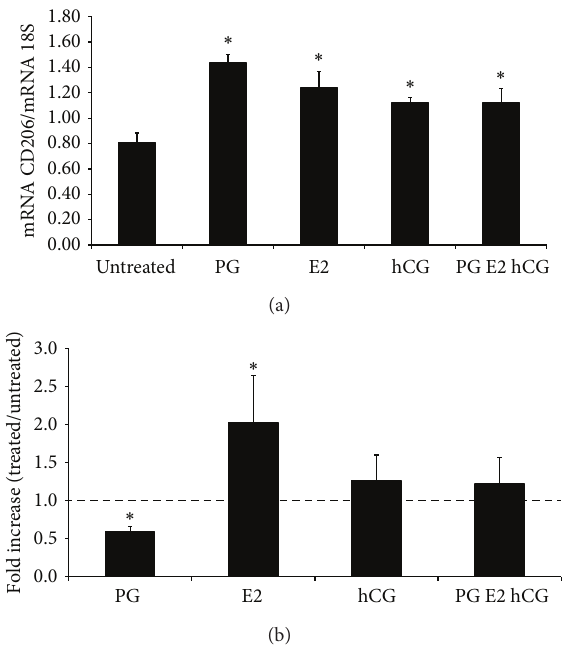
Figure 5: Expression of CD206 and PCT in human macrophages conditioned for 24 hours with PG, E2, and hCG or with the three hormones combined together. (a) The mRNA expression level of CD206 was measured by qPCR and normalized to those of the human housekeeping gene 18S. Results were expressed as AUs, in which 1AU represents the value obtained with macrophages cultured in NHS used as a positive control. (b) PCT fold increase was expressed as ratio between mRNA levels of LPS stimulated and LPS untreated cells. Bars represent the mean ± S.E.M. of at least 3 independent experiments. ∗ 𝑃 < 0.05 (Mann-Whitney